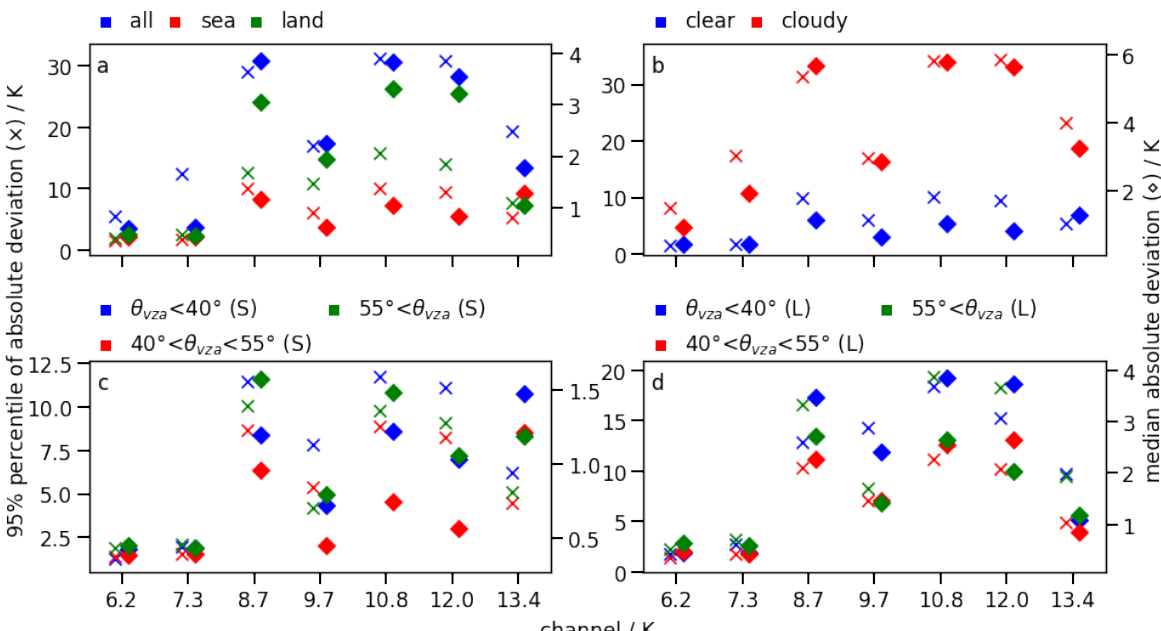
Figure 9. The 95th percentile (cross) and median (diamond) of the absolute deviation between the simulated brightness temperatures and the corresponding MSG/SEVIRI measurements; considered is the full dataset ( all ) ( a ) as well as subsets, i.e., ( a ) land and sea for cloud-free samples (i.e., no cloud layers simulated, total cloud cover ≤ 0.25), ( b ) clear and cloudy (i.e., at least one cloud layer simulated and total cloud cover ≥ 0.25) for sea surfaces and ( c ) different θ vza above sea and ( d )